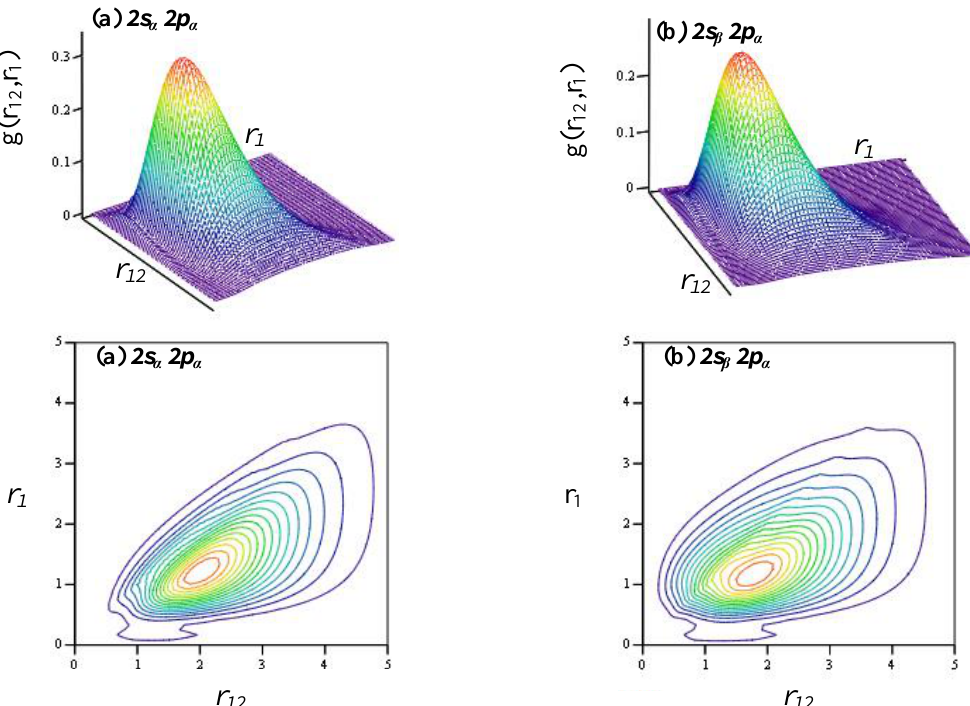
Fig. 9: The surfaces and contours of the partial distribution